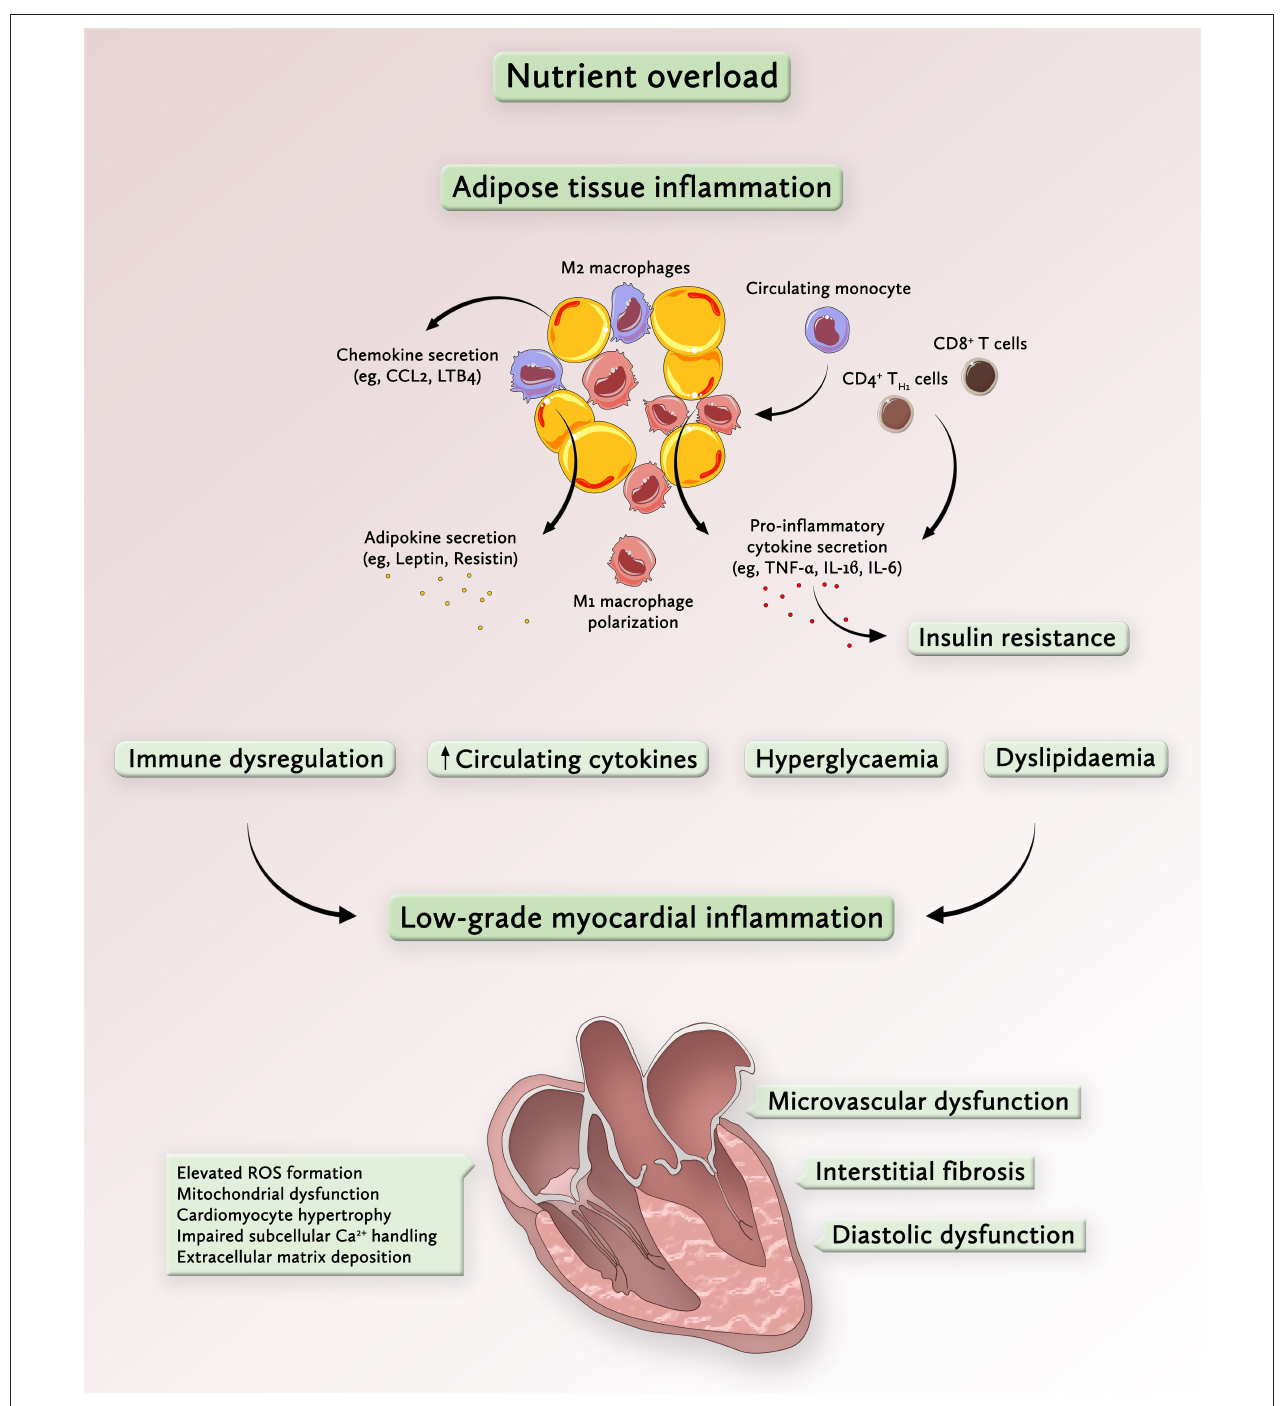
FIGURE 1 | Overnutrition drives metabolic inflammation and promotes a low-grade inflammatory state in the heart. Chronic nutrient overload induces adipose tissue expansion, which enhances the secretion of chemotactic signals, such as chemokine-ligand 2 (CCL2) from enlarging adipocytes. Transmigration of chemokine-ligand receptor 2 (CCR2) + circulating monocytes into the adipose tissue represents a key event in the development of systemic inflammation in response to nutrient overload. Given the pro-inflammatory milieu, recruited monocytes assume an inflammatory M1 macrophage phenotype, a process that is further accelerated by activated CD8 + T cells and CD4 + TH1 cells. The release of inflammatory cytokines causes insulin resistance, commonly associated with hyperglycemia, dyslipidemia and immune dysregulation. These processes contribute to the activation of inflammatory pathways in the myocardium which are linked to enhanced ROS formation and mitochondrial dysfunction, cardiomyocyte growth and extracellular matrix deposition. Collectively, these alterations on both systemic and myocardial levels drive microvascular dysfunction, interstitial fibrosis and diastolic dysfunction, key features of metabolic cardiomyopathy. CCL2 denotes chemokine ligand 2; IL, interleukin; LB4, leukotriene B4; ROS, reactive-oxygen species; TNF- α , tumor necrosis factor alpha.